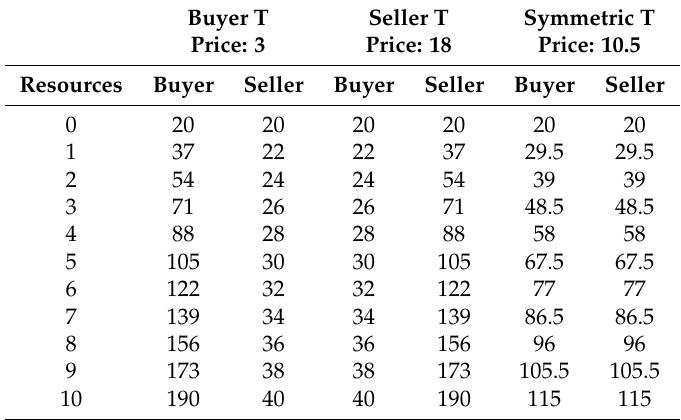
Table 2. Payoffs for Buyers and Sellers by